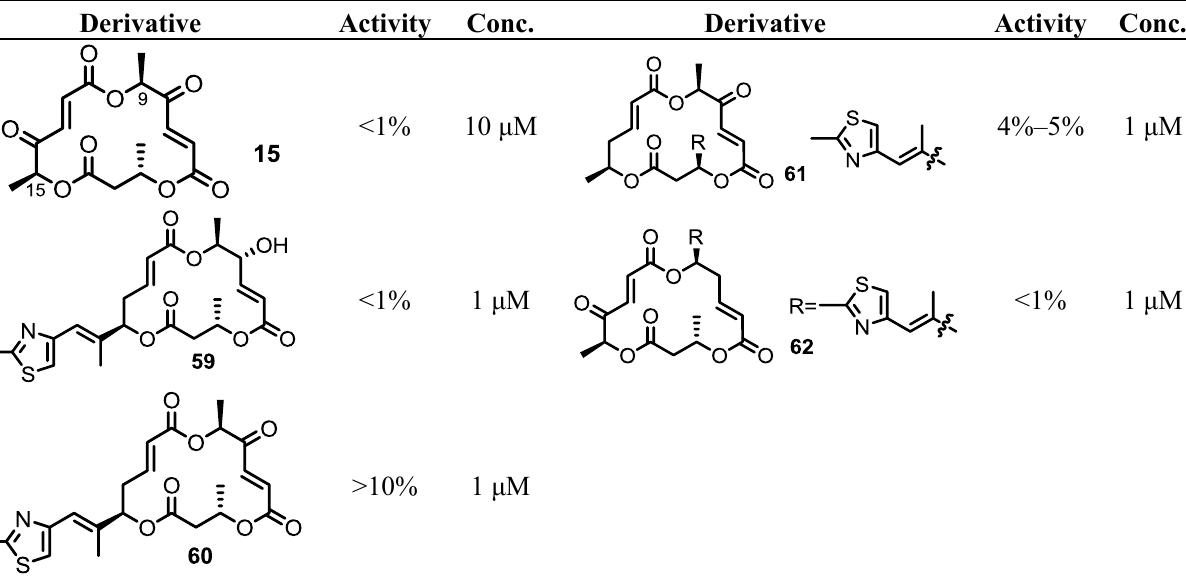
Table 1. Apoptosis Inducing Activity of MS Derivatives a,b,c